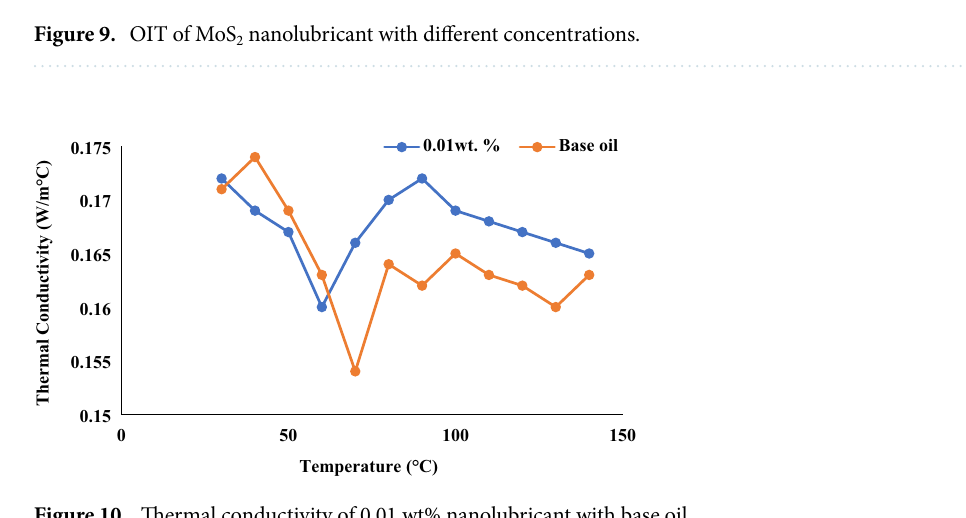
Figure 10. Thermal conductivity of 0.01 wt% nanolubricant with base